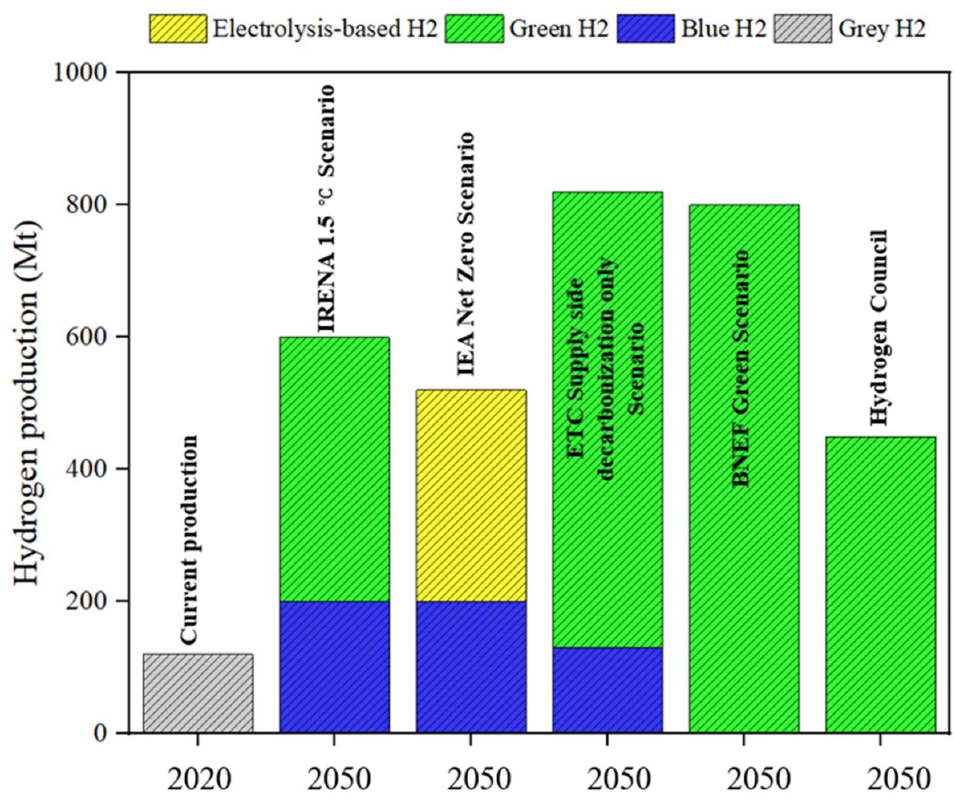
Figure 2. Hydrogen production by source by 2050 according to different agency assessments. Based on data from Ref. [36].